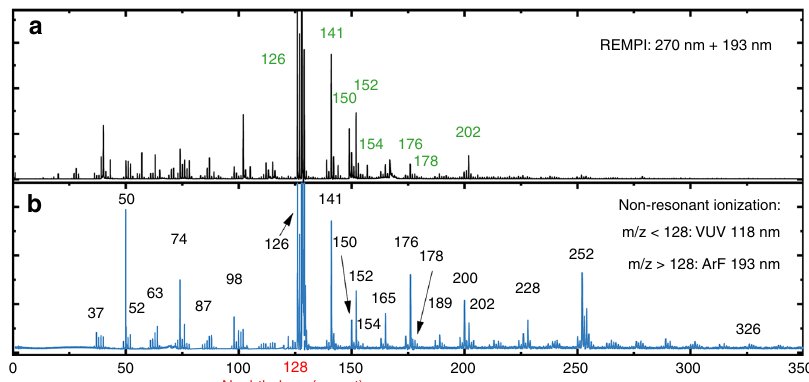
Fig. 1 Mass spectra of products and fragments from naphthalene formed in electrical discharge. Trace a is recorded with two-color REMPI during our IR- UV ion dip measurements. Products that are assigned to a molecular structure are labeled with their masses in green, see Figs. 2 and 3. Trace b is taken using 118 nm VUV for the region below m / z = 128 and 193 nm UV for the region above m / z = 128. The m / z = 326 would correspond to a formed cyclic structure containing seven aromatic